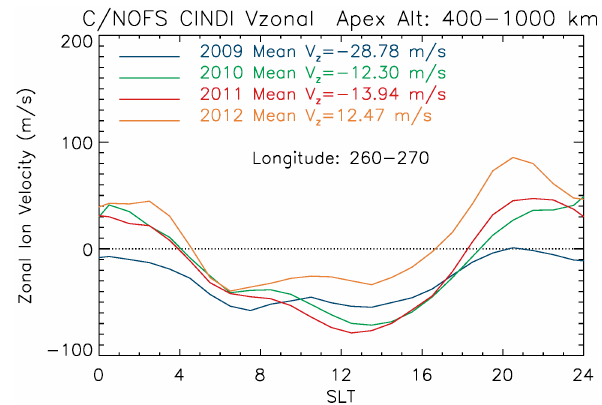
465 Figure 9. Similar to Figure 7 except for the 10–16 SLT range. 466 467 Fig. 9. Similar to Fig. 7 except for the 10:00–16:00SLT range. 468